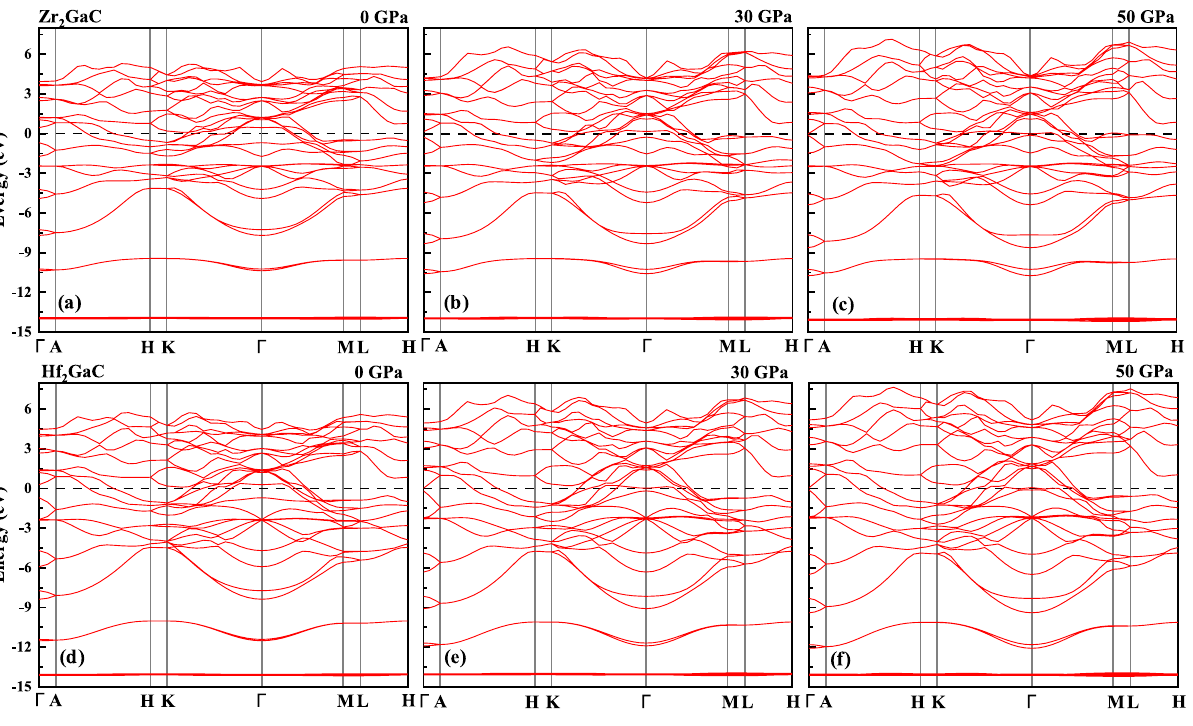
Figure 4. Band structure for Zr 2 GaC at a 0 pressure, b 30 GPa, and c 50 GPa, and for Hf 2 GaC at d 0 pressure, e 30 GPa, and f 50 GPa. Fermi level is set to 0 eV.